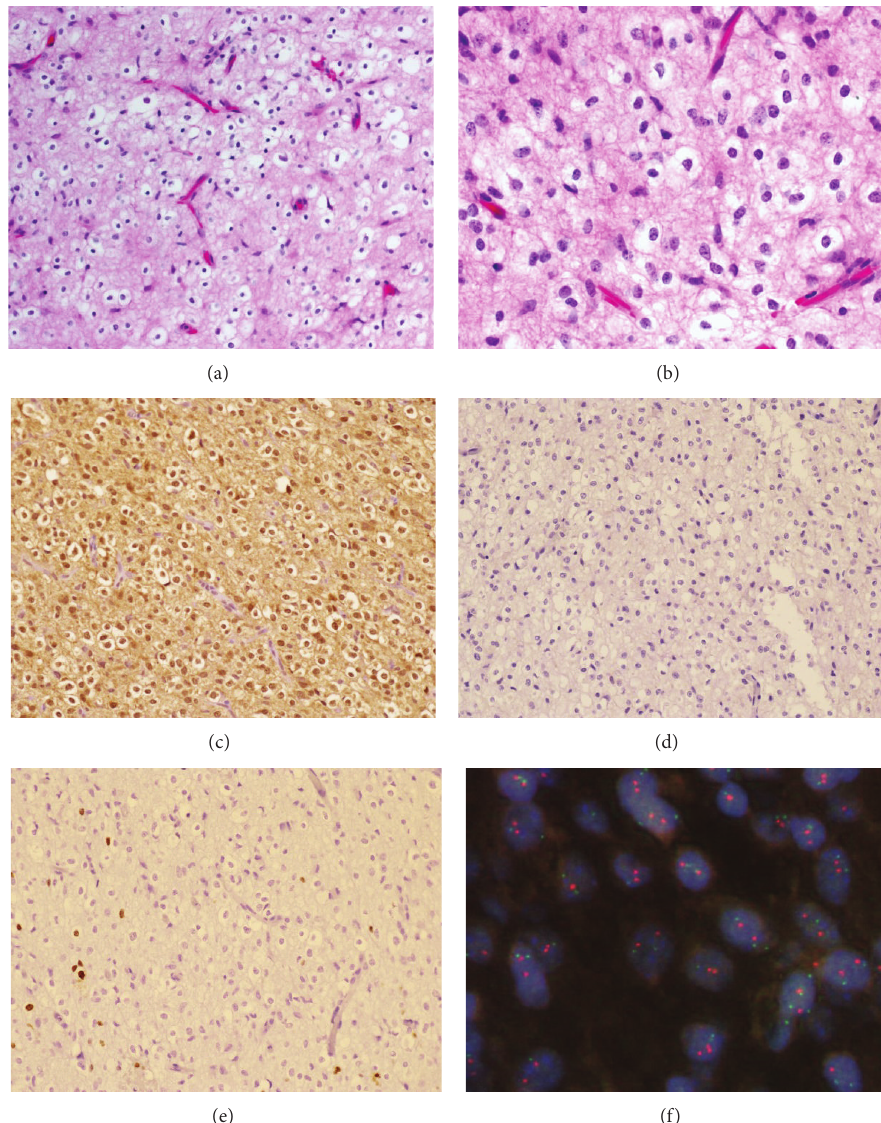
Figure 2: H&E stained sections at 20x (a) and 40x (b). Cytoplasmic and nuclear staining with S100 (c). Negative staining for mutant specific (R132H) IDH-1 (d). Low proliferation index ( < 1%) by Ki67 immunohistochemistry (e). Intact 1p and 19q by FISH